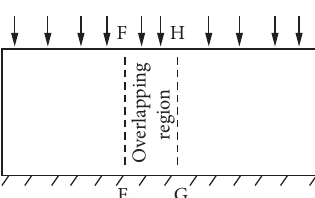
Figure 2: Boxed-shape